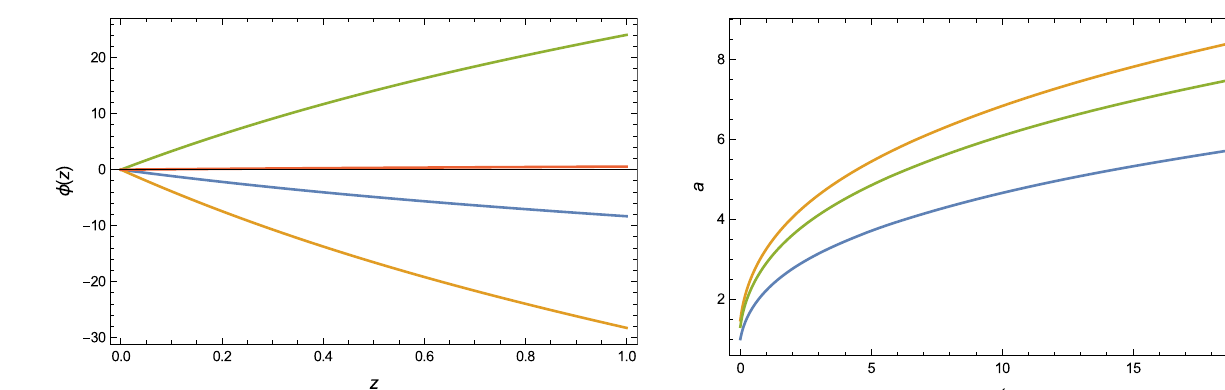
Fig. 16 Evolution of scale factor with respect to cosmic time. The various colors take on the following values of α . Blue: α = − 100, green: α = − 500, yellow: α = − 1000